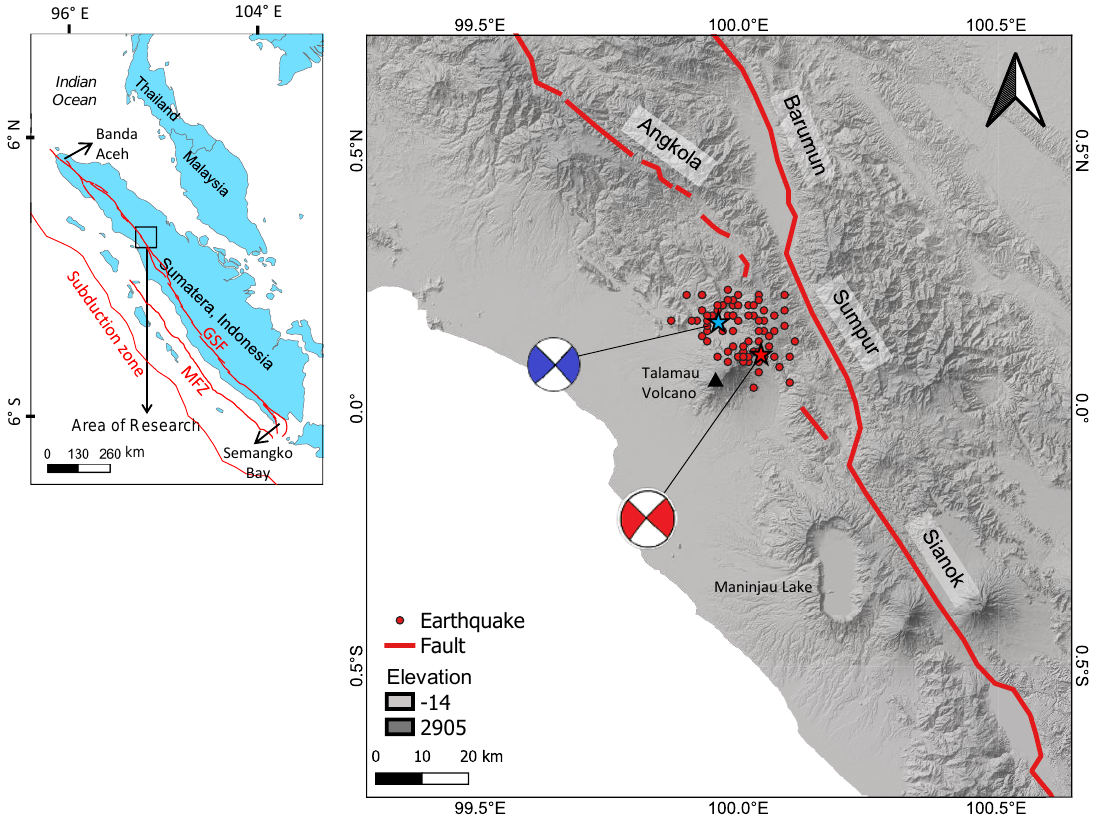
Figure 1. Study area and earthquake location map. White – blue and white – red beach balls show the earthquake that occurred at 08:35 and 08:39 local time, respectively, while the blue and red stars are the epicenter locations. The black triangle is the location of Talamau Volcano.